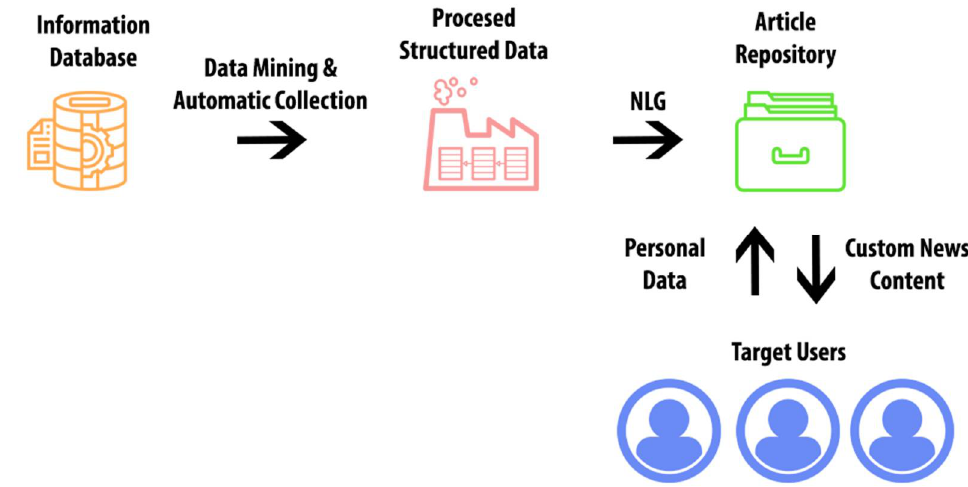
Figure 3. Structural example of a fully autonomous news system.